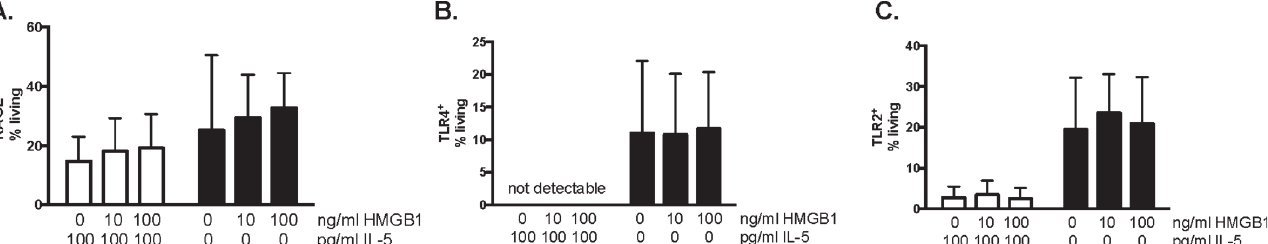
Fig 2. HMGB1 has no impact on cell surface expression of RAGE, TLR2 or TLR4. Eosinophils isolated from peripheral blood of normal donors incubated in the presence (open bars) or absence (closed bars) of IL-5 with 0, 10 or 100 ng/ml HMGB1for 48 hours and then evaluated for the expression of (A) RAGE, (B) TLR4, and (C) TLR2. Data represent mean ± SEM of percent population of live eosinophils that are positive for indicated receptor minus staining with isotype control; n = 3 independent donors.